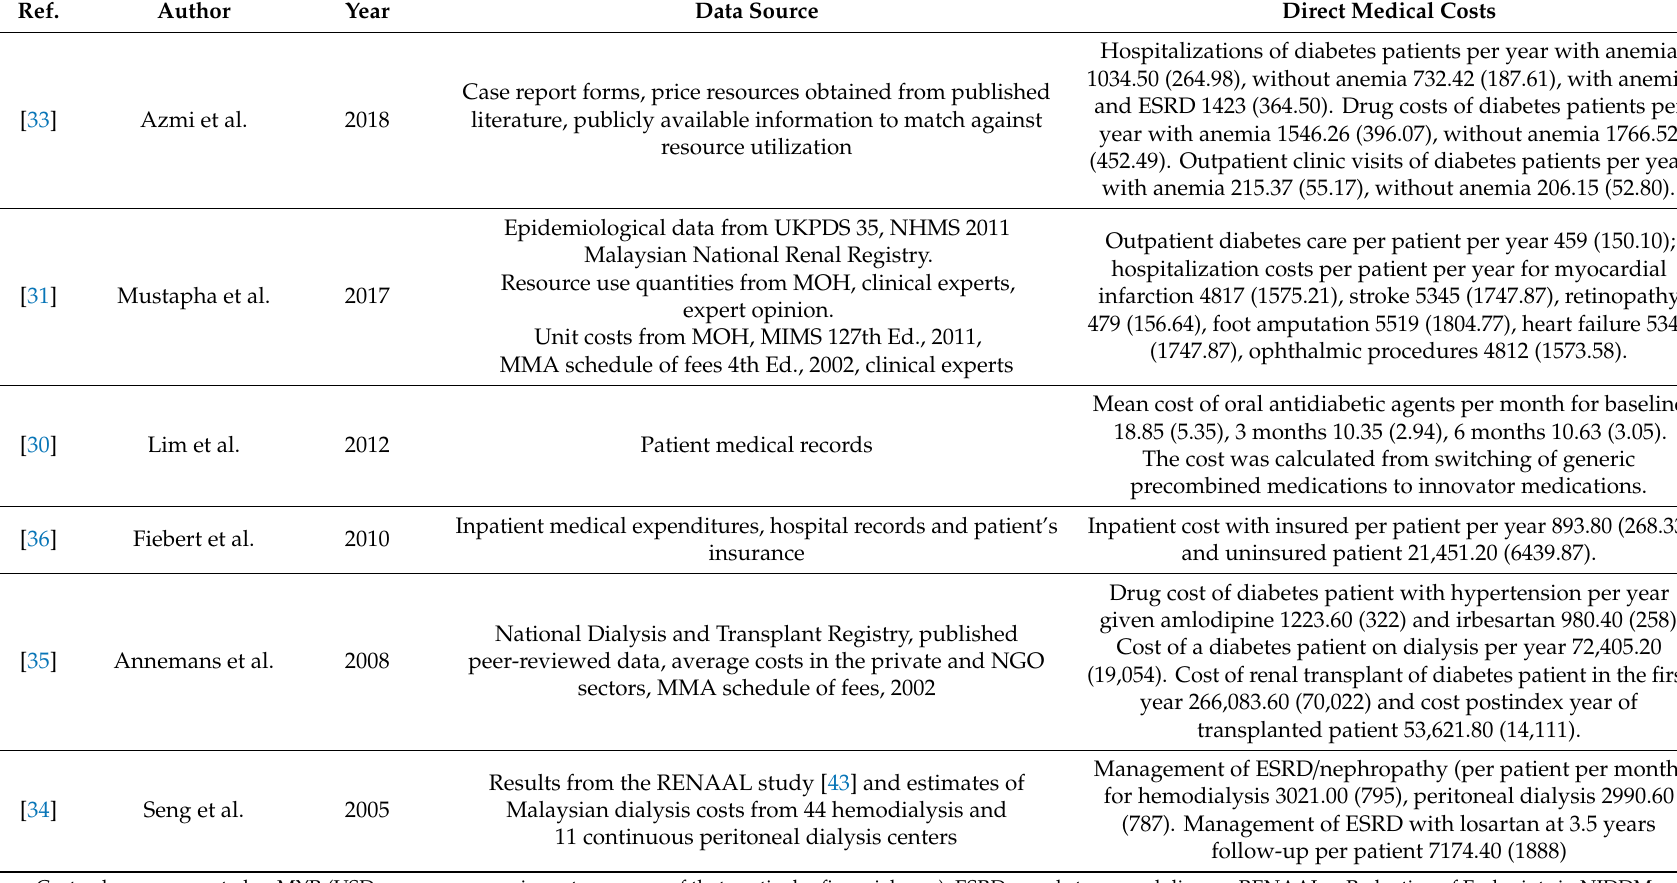
Table 3. The direct medical costs for type 2